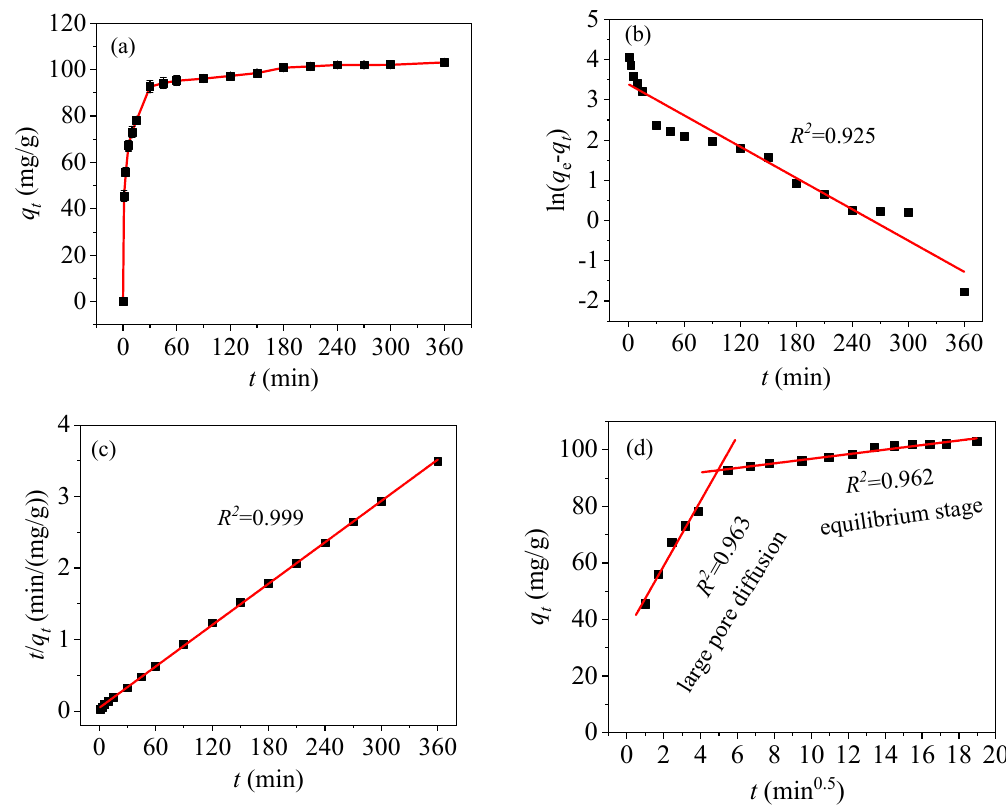
Figure 12. Kinetics of q t vs. t ( a ), pseudo-first-order ( b ), pseudo-second-order ( c ), and intra-particle di ff usion models ( d